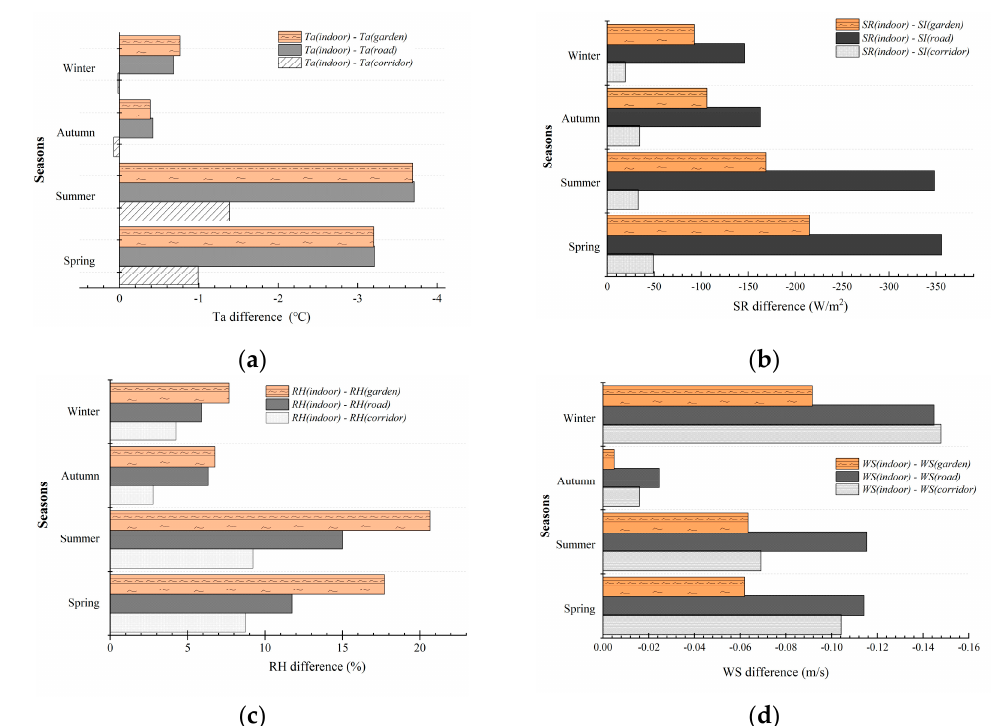
Figure 6. The seasonal microclimatic differences of indoor and outdoor spaces. ( a ) T a ; ( b ) SR; ( c ) RH; ( d )